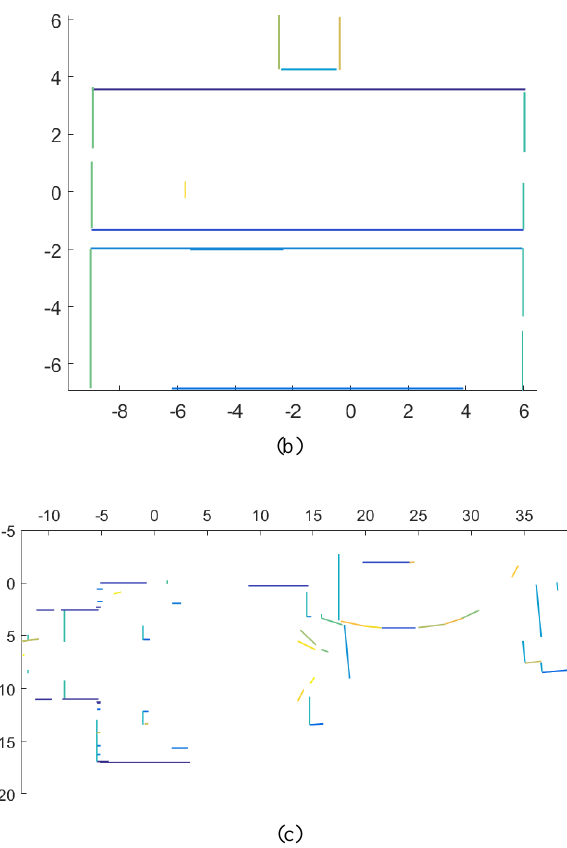
Figure 10. Identification of walls – 2D planes generated: (a) individual house No.1 – garden level; (b) individual house No.2 – basement level; (c) Haussmann building – ground